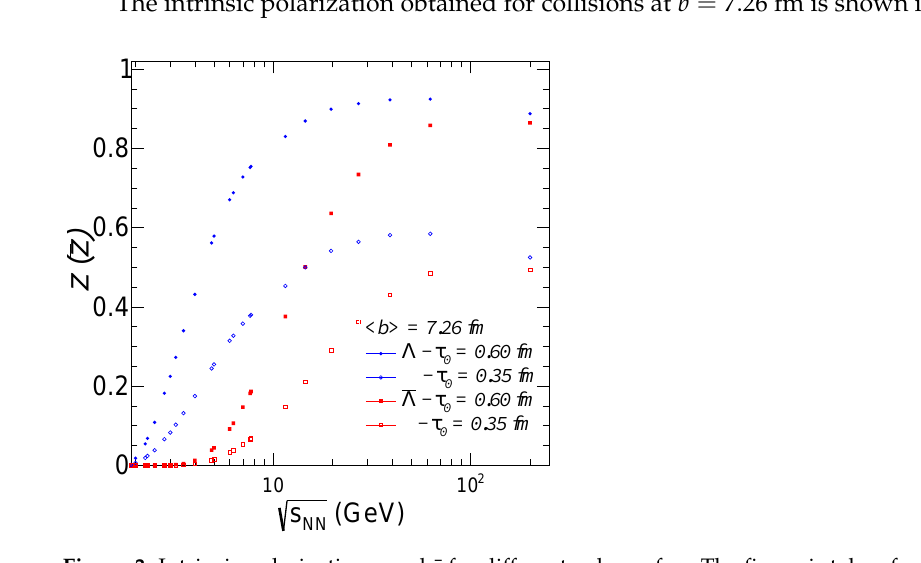
Figure 3. Intrinsic polarization z and ¯ z for different values of τ 0 . The figure is taken from Ref.